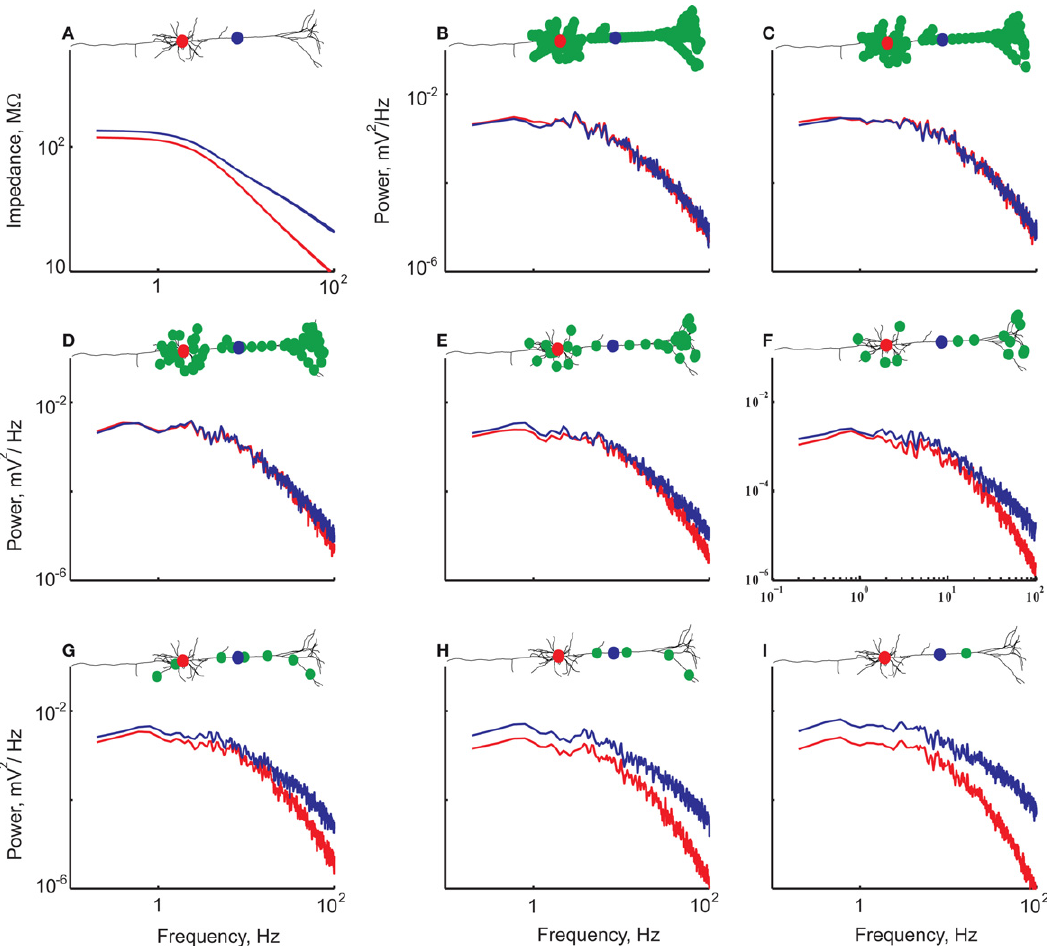
Figure 4 | A passive model of a L5 neuron exhibits a difference in input impedance at soma and dendrite yet shows similar voltage noise spectra at these sites when identical noise sources are uniformly distributed over the tree. Insets depict the neuron model with the recording sites depicted as a red circle (soma) and a blue circle (dendrite). The location(s) of the noise sources are depicted by the green dots. (A) Impedance measured at the soma (red) and 475 μ m in the apical dendrite (blue). (B–I) The noise spectra calculated at the two recording sites having different values of uniformly distributed, densities of identical noise sources. Total number of noise sources: (A) 0; (B) 267 (C) 137; (D) 67; (E) 32; (F) 16; (G) 8; (H) 4; (I) 1. The decrease in noise source density (B–I) is compensated for by a corresponding increase in input frequency for each noise